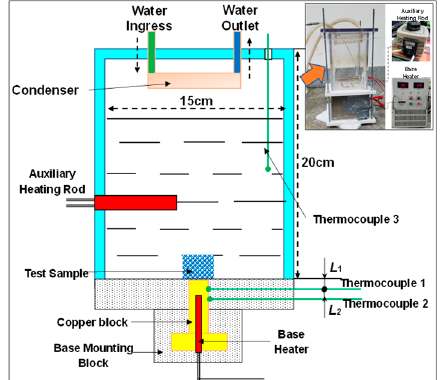
Figure 9. Schematic of boiling heat transfer experimental equipment including a boiling heat transfer test device, an auxiliary heating control device, a main heating control device, and a data acquisition device